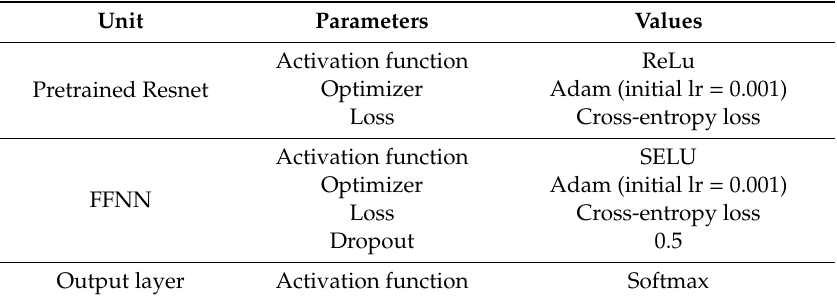
Table 2. Testing configurations for performance evaluation. Adam, adaptive moment estimation; scaled exponential linear unit (SELU), scaled exponential linear